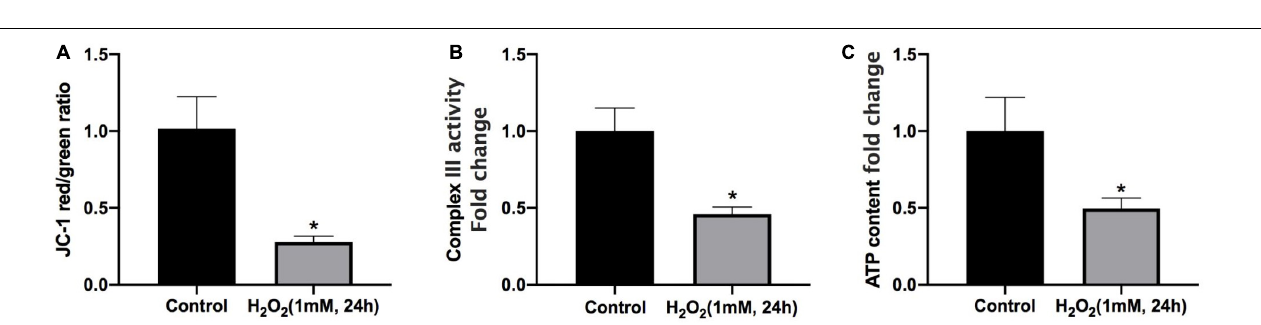
FIGURE 4 | Mitochondrial dysfunction is involved in H 2 O 2 -induced apoptosis of rat NP. (A) Effect of H 2 O 2 on mitochondrial membrane potential. (B) Summary data for the effect of H 2 O 2 on the relative content of complex III. (C) Intracellular ATP levels in NP cells. * p < 0.05 vs. control